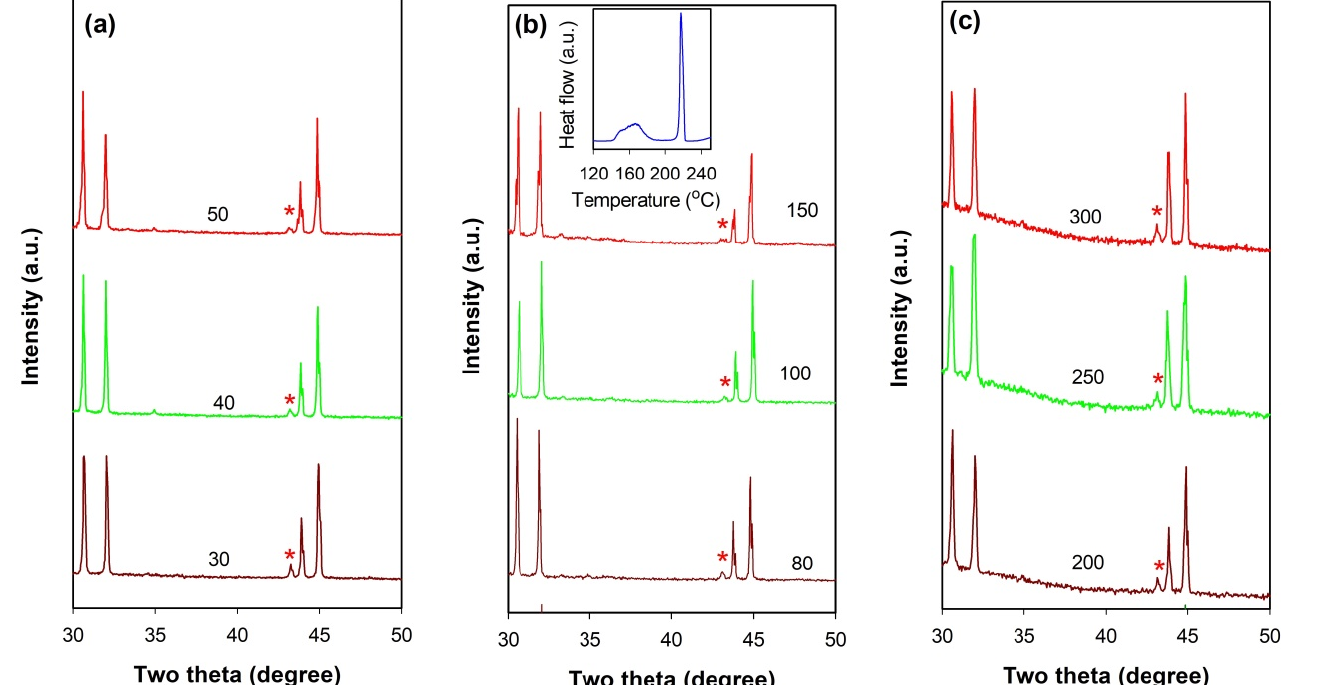
Figure 11. XRD patterns of SnZnCu@SiO 2 microspheres (encapsulation times = 3) after different numbers of thermal cycles: ( a ) SnZn 0.04 Cu 0.015 @SiO 2 , ( b ) SnZn 0.04 Cu 0.02 @SiO 2 , and ( c ) SnZn 0.04 Cu 0.03 @SiO 2 . The Cu 5 Zn 8 phase is indicated by a red star. The inset of Figure 10b is the DSC curve of the SnZn 0.04 Cu 0.02 @SiO 2 microspheres after 150 thermal cycles.